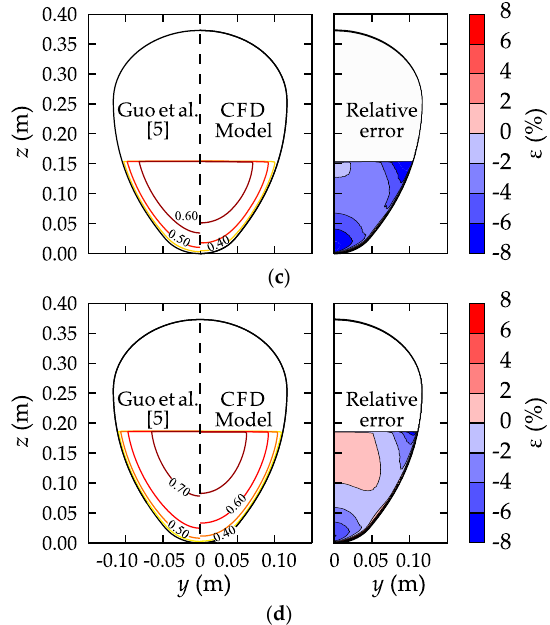
Figure 4. Comparison of velocity contours and relative errors for h/H = 0.2 ( a ); 0.3 ( b ); 0.4 ( c ); 0.5 ( d ). Left data from Equation (3) and right for numerical model. Velocity contours are expressed in m/s.